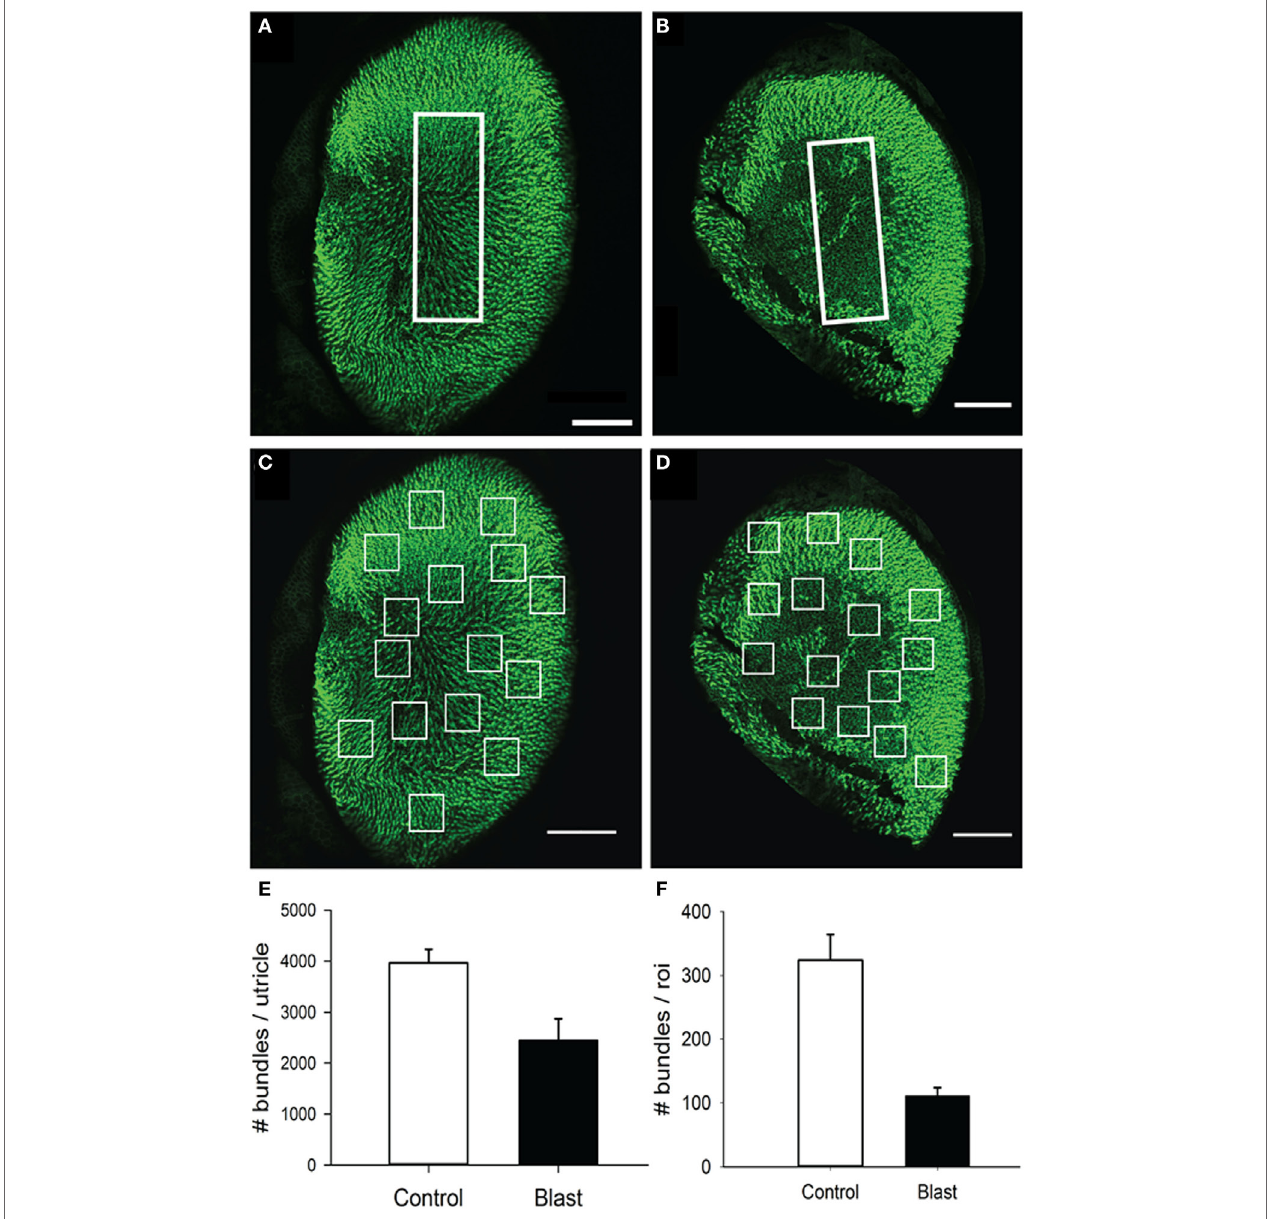
FigUre 9 | Stereocilia bundles in the utricle. Images of the utricle from in control (a,c) and blast (B,D) animals at 28 days after sham or blast exposure. Stereocilia bundles were stained with phalloidin (green). (a,B) Stereocilia counts were obtained from a central zone counting frame (60 µm × 100 µm, white box). (c,D) 15 Random placed counting frames (50 µm × 50 µm) were generated to obtain estimates of the total number of stereocilia bundles per utricle in both control and blast animals. (e) The mean number of stereocilia bundles for the central zone counting frame in control (white) or blast (black). (F) Mean stereocilia bundle counts averaged across the 15 random counting frames for control (white) or blast (black) animals. Scale bars: 100